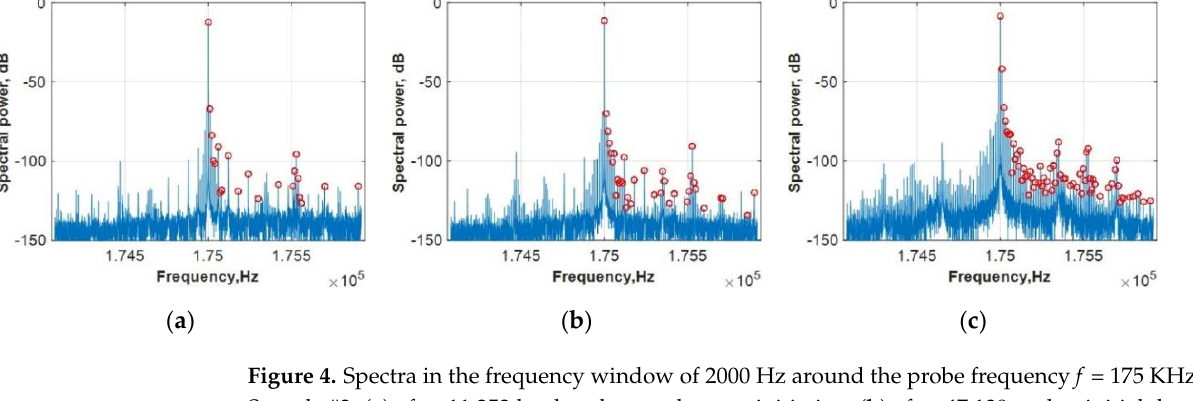
Figure 4. Spectra in the frequency window of 2000 Hz around the probe frequency f = 175 KHz for Sample #3: ( a ) after 11,252 load cycles, no damage initiation; ( b ) after 47,139 cycles, initial damage accumulation; ( c ) after 51,219 cycles, visible crack. The number of cycles to failure was 52,106 (see Table 2).